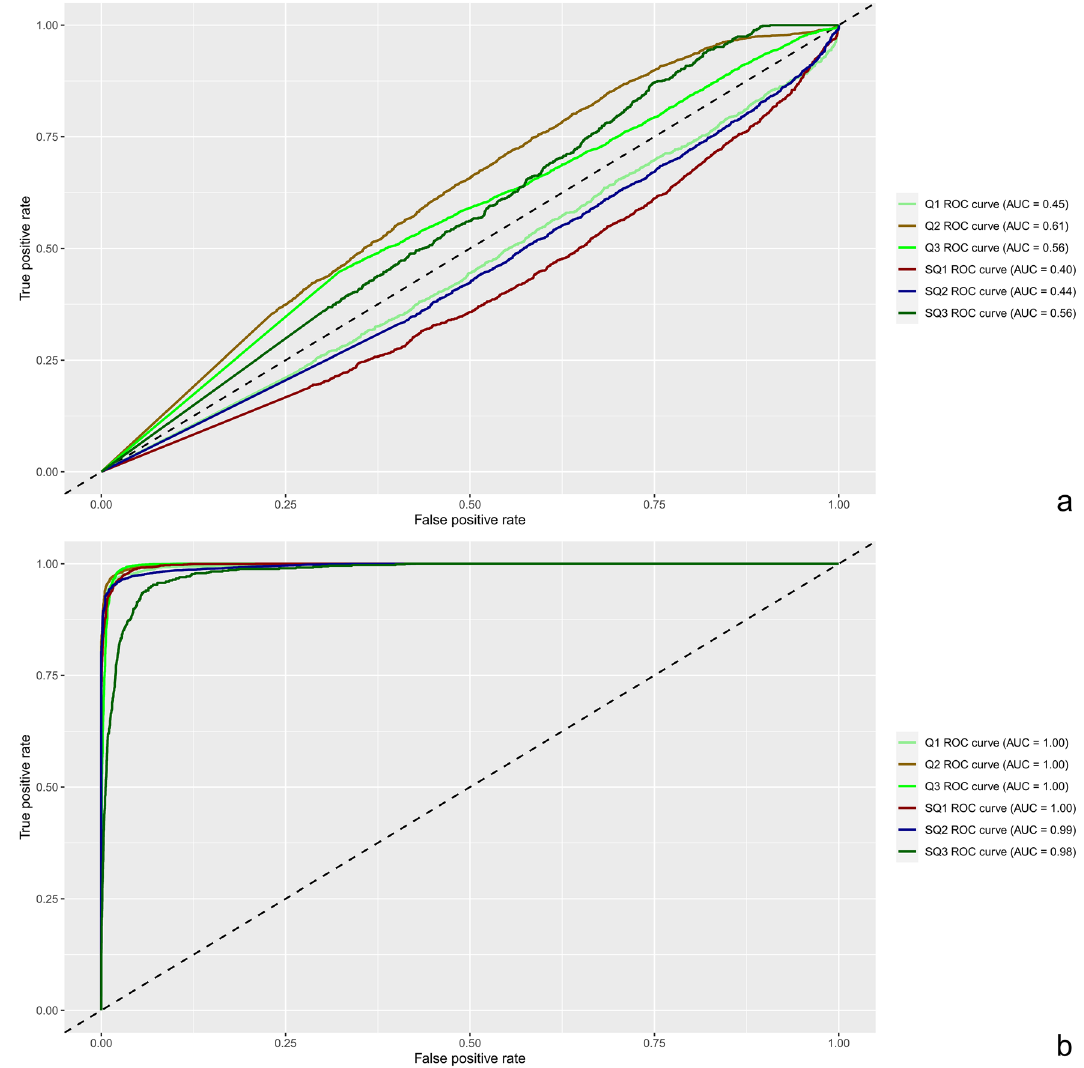
Figure 4. Receiver operating characteristic (ROC) curves and area under the curve (AUC) results regarding the performance of MLP in predicting clustering by by SCYLV titer determined by RT-qPCR (Q) and SCYLV titer determined by RT-qPCR and SCYL symptom severity (SQ). ( a ) Model performance obtained using the full marker dataset. ( b ) Model performance obtained using the marker dataset obtained from the intersection of at least two of the three best feature selection methods employed in the study